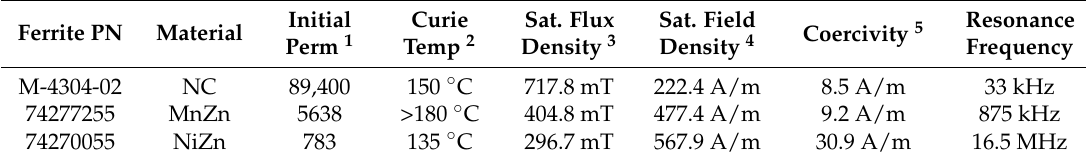
Table 2. Magnetic properties of cable ferrites.